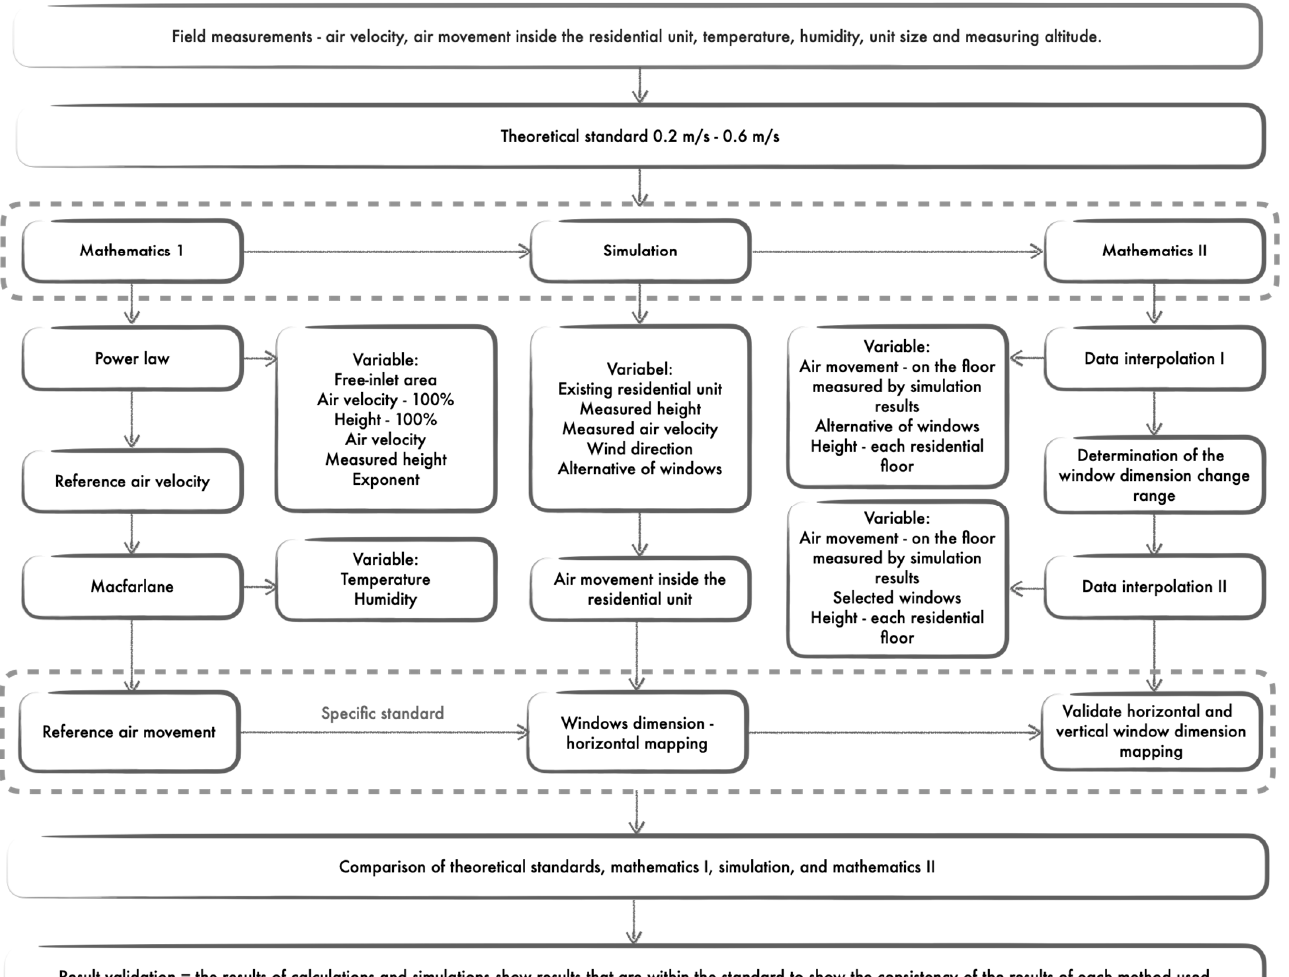
Figure 7. Research workflow.